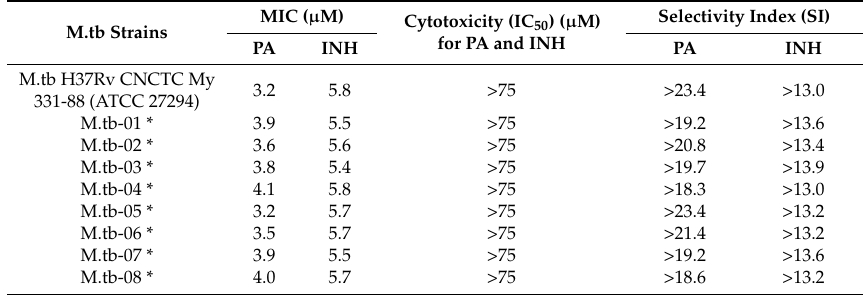
Table 1. In vitro antimycobacterial and cytotoxicity activities of PA and INH against M.tb